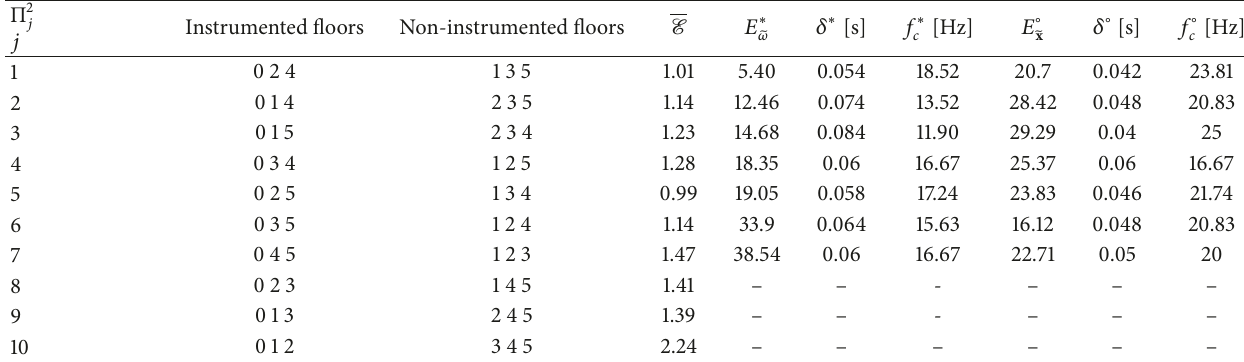
Table 5: Results with two instrumented floors.